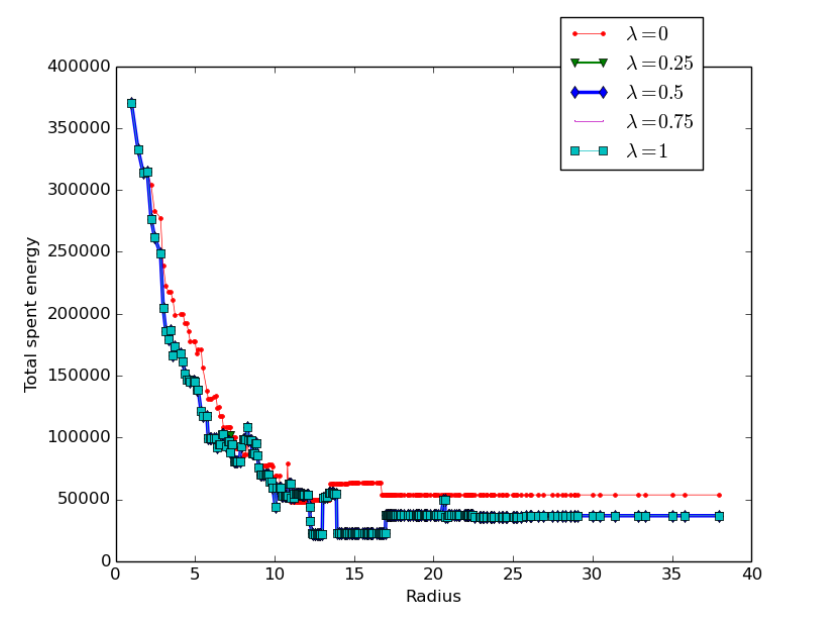
Figure 13. Impact of the cluster-head selection